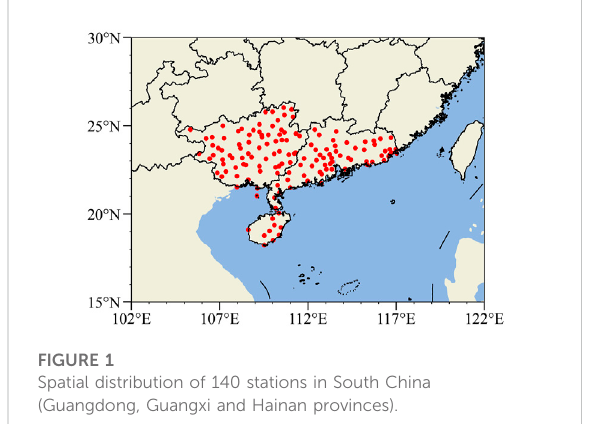
FIGURE 1 Spatial distribution of 140 stations in South China (Guangdong, Guangxi and Hainan